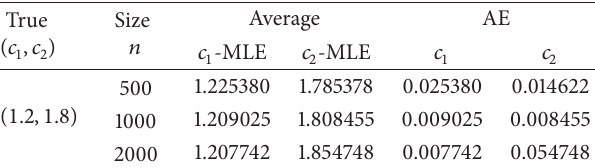
Table 3: The simulation values of the MLE of (𝑐 1 ,𝑐 2 ) when Δ𝑡 = 0.1 .